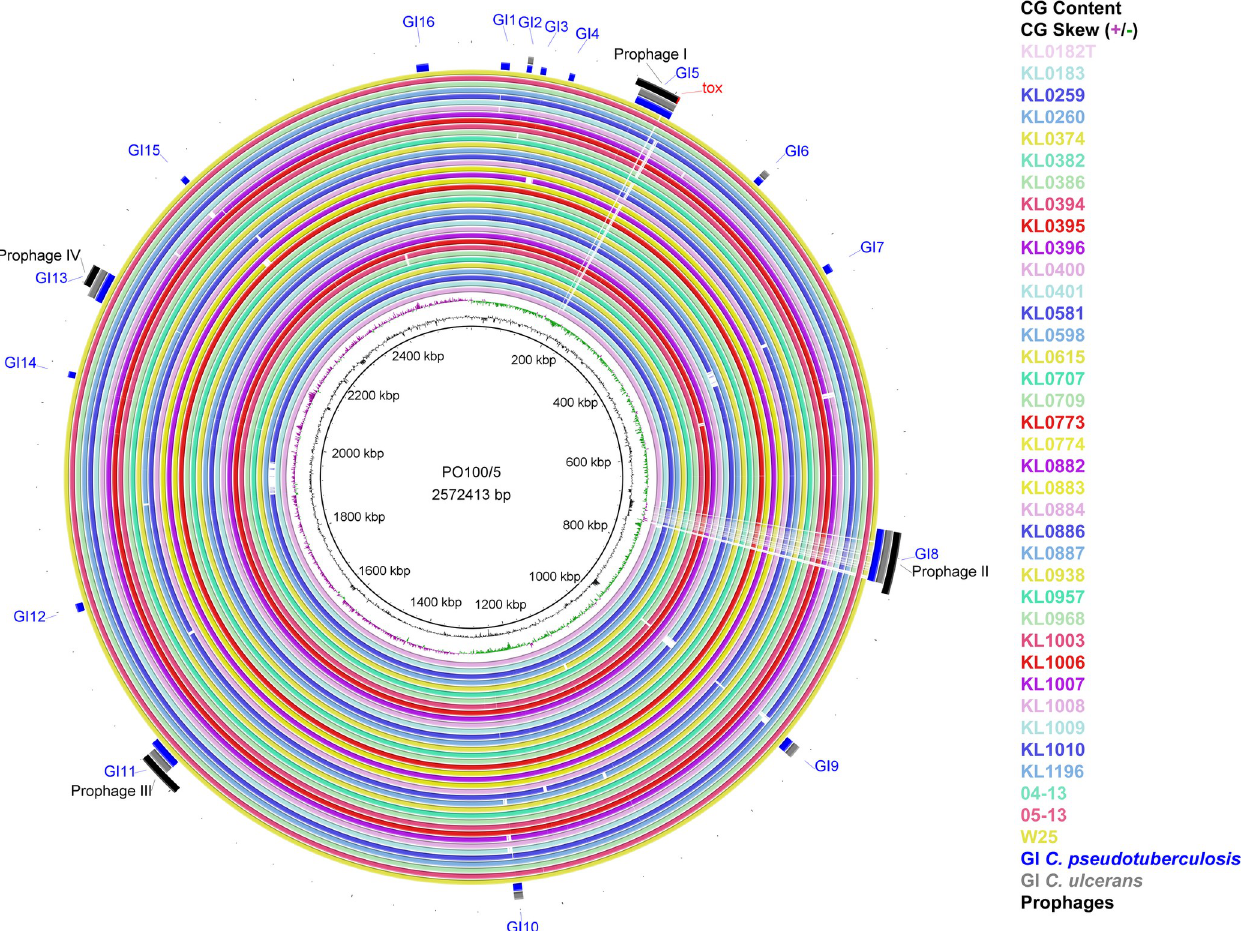
Fig 4. Circular map of Corynebacterium silvaticum genomes generated using BRIG v0.95. From inner to outer circle: strain PO100/5 (reference); CG content; CG Skew; strains KL0182 T , KL0183, KL0259, KL0260, KL0374, KL0382, KL0386, KL0394, KL0395, KL0396, KL0400, KL0401, KL0581, KL0598, KL0615, KL0707, KL0709, KL0773, KL0774, KL0882, KL0883, KL0884, KL0886, KL0887, KL0938, KL0957, KL0968, KL1003, KL1006, KL1007, KL1008, KL1009, KL1010, KL1196, 04–13, 05–13, W25; genomic islands compared to C . pseudotuberculosis ATCC19410 T (blue) and C . ulcerans strain NCTC7910 T (grey); and prophages (black). Genomic islands (GI) and prophage detection were performed using GIPSy and PHASTER, respectively.